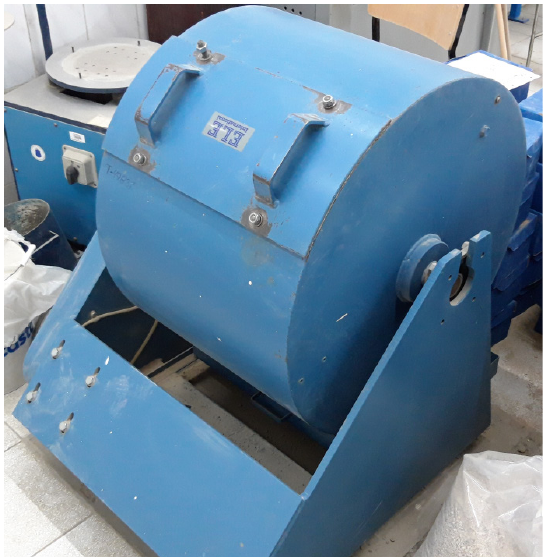
Figure 2: Los Angeles drum.